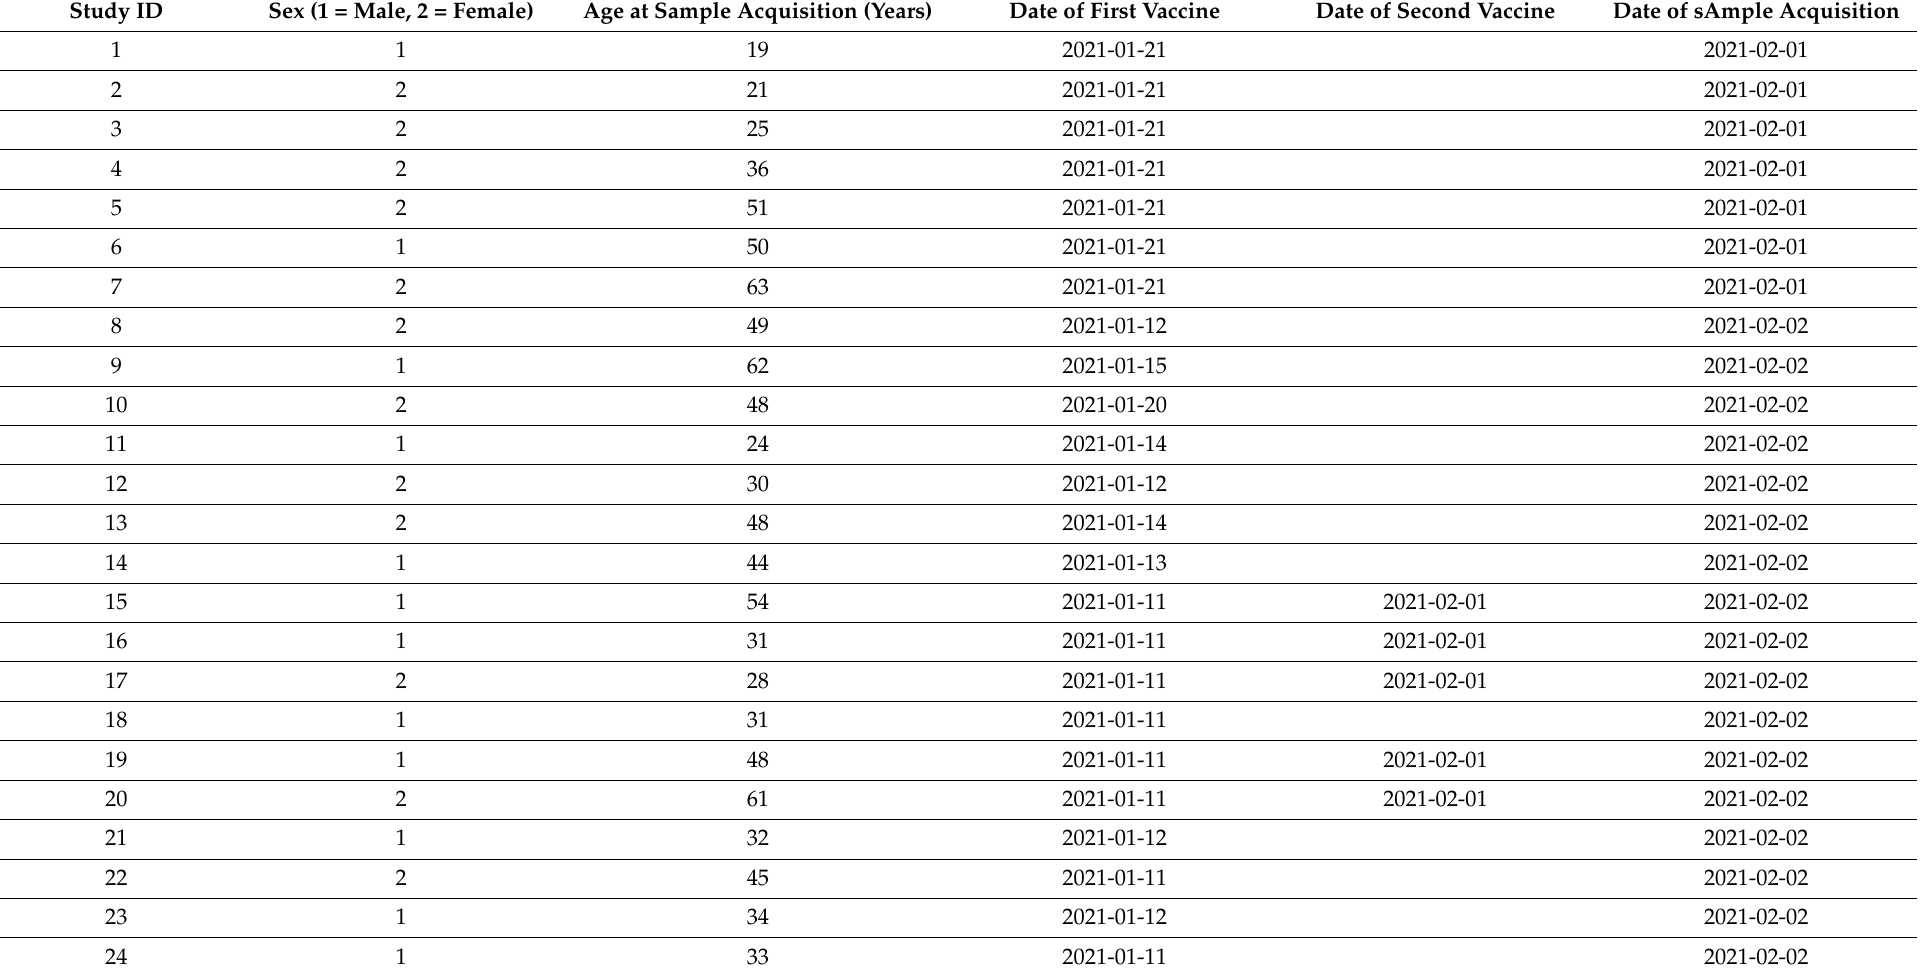
Table A1. Vaccinee-specific raw